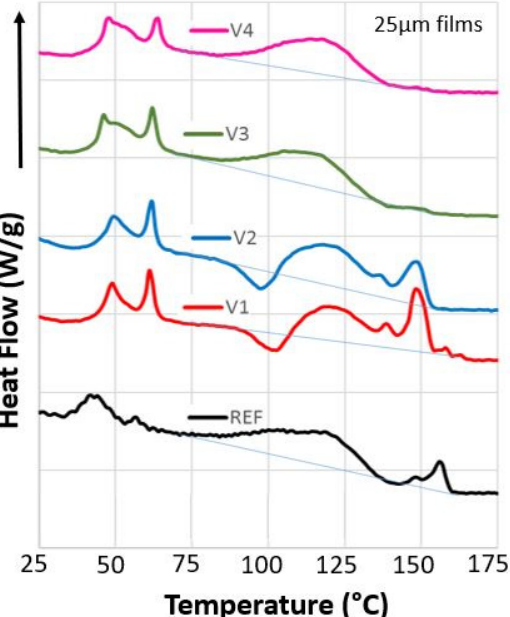
Figure 3. DSC traces of REF, V1 to V4, first runs (0.2 W/g) of 25 µm films with glass temperature T g,hs , the THF boiling temperature T THF , melting temperatures T m 1 and T m 2 , and corresponding melting and crystallization